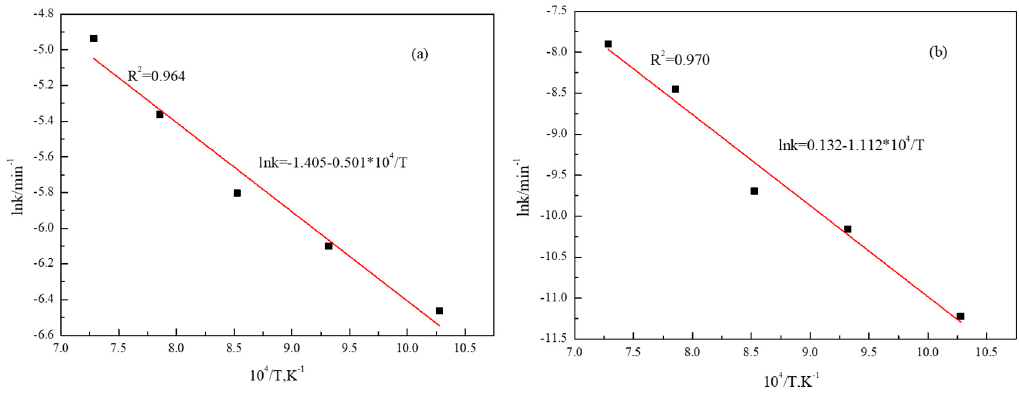
Figure 6. The Arrhenius plot of reaction degree constant k vs. temperature ( a ) intrinsic chemical reaction control step and ( b ) diffusion control step at 973 K–1373 K in H 2 /(H 2 + CO) = 1/2 atmosphere.